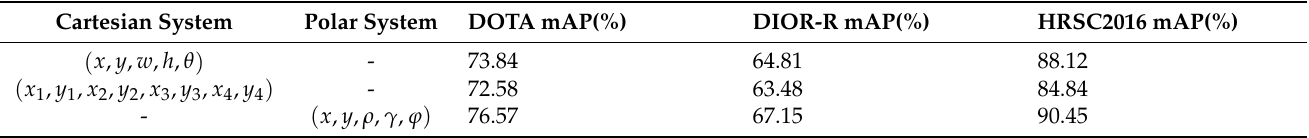
Table 6. Ablation study of proposed polar representation method of